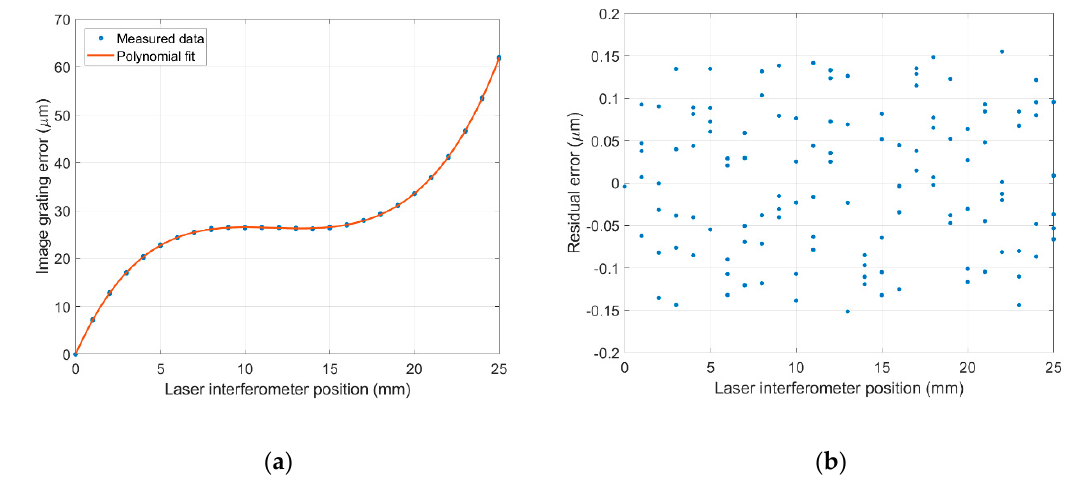
Figure 12. ( a ) Fifth-degree polynomial fitting; ( b ) Residual errors after polynomial fitting.